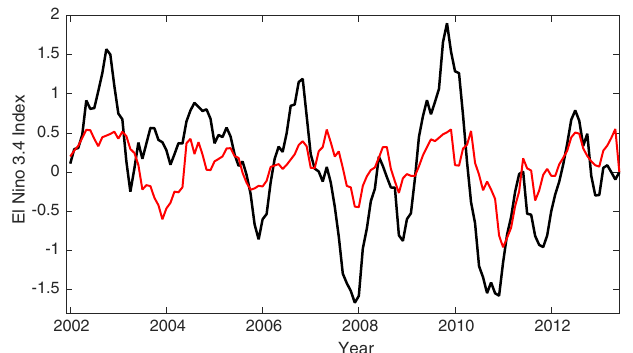
FIG. 9. The Kalman-Takens method is used to filter a set of historical data from the El Niño 3.4 index. The resulting 14-month lead nonparametric diffusion forecast using the filtered historical data is shown (solid red curve). The forecasted trajectory captures the general pattern of the true trajectory (solid black